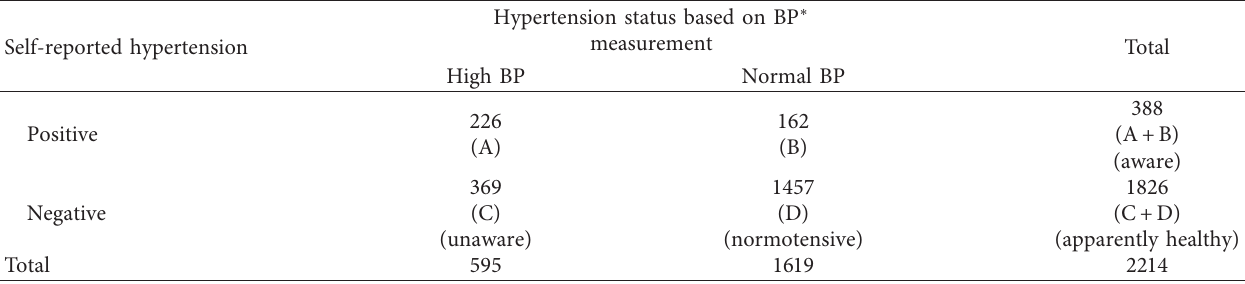
Table 1: Mapping self-reported hypertension based on face-to-face interviews against hypertension based on blood pressure